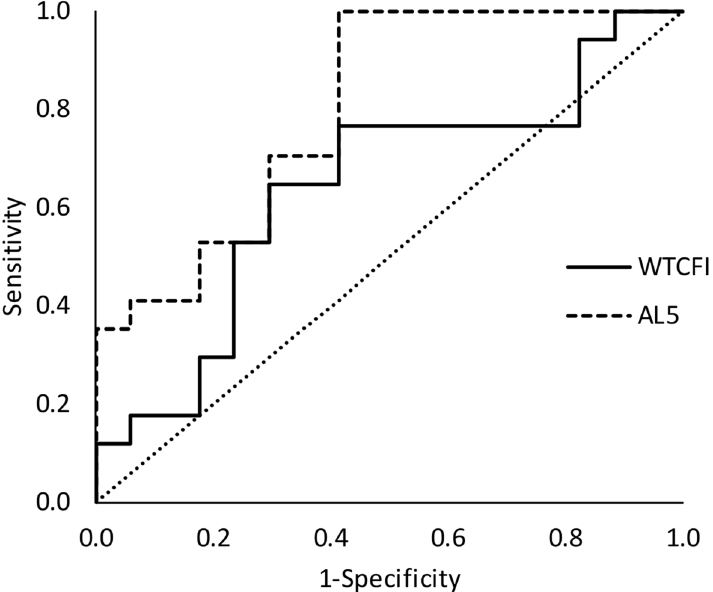
Figure 6. ROC Curves for SDB classification of pre- and after CPAP therapy in severe patients (n: 15) according to their night activity level (AL5, discontinuous line) versus wrist temperature robustness (WTCFI, continuous